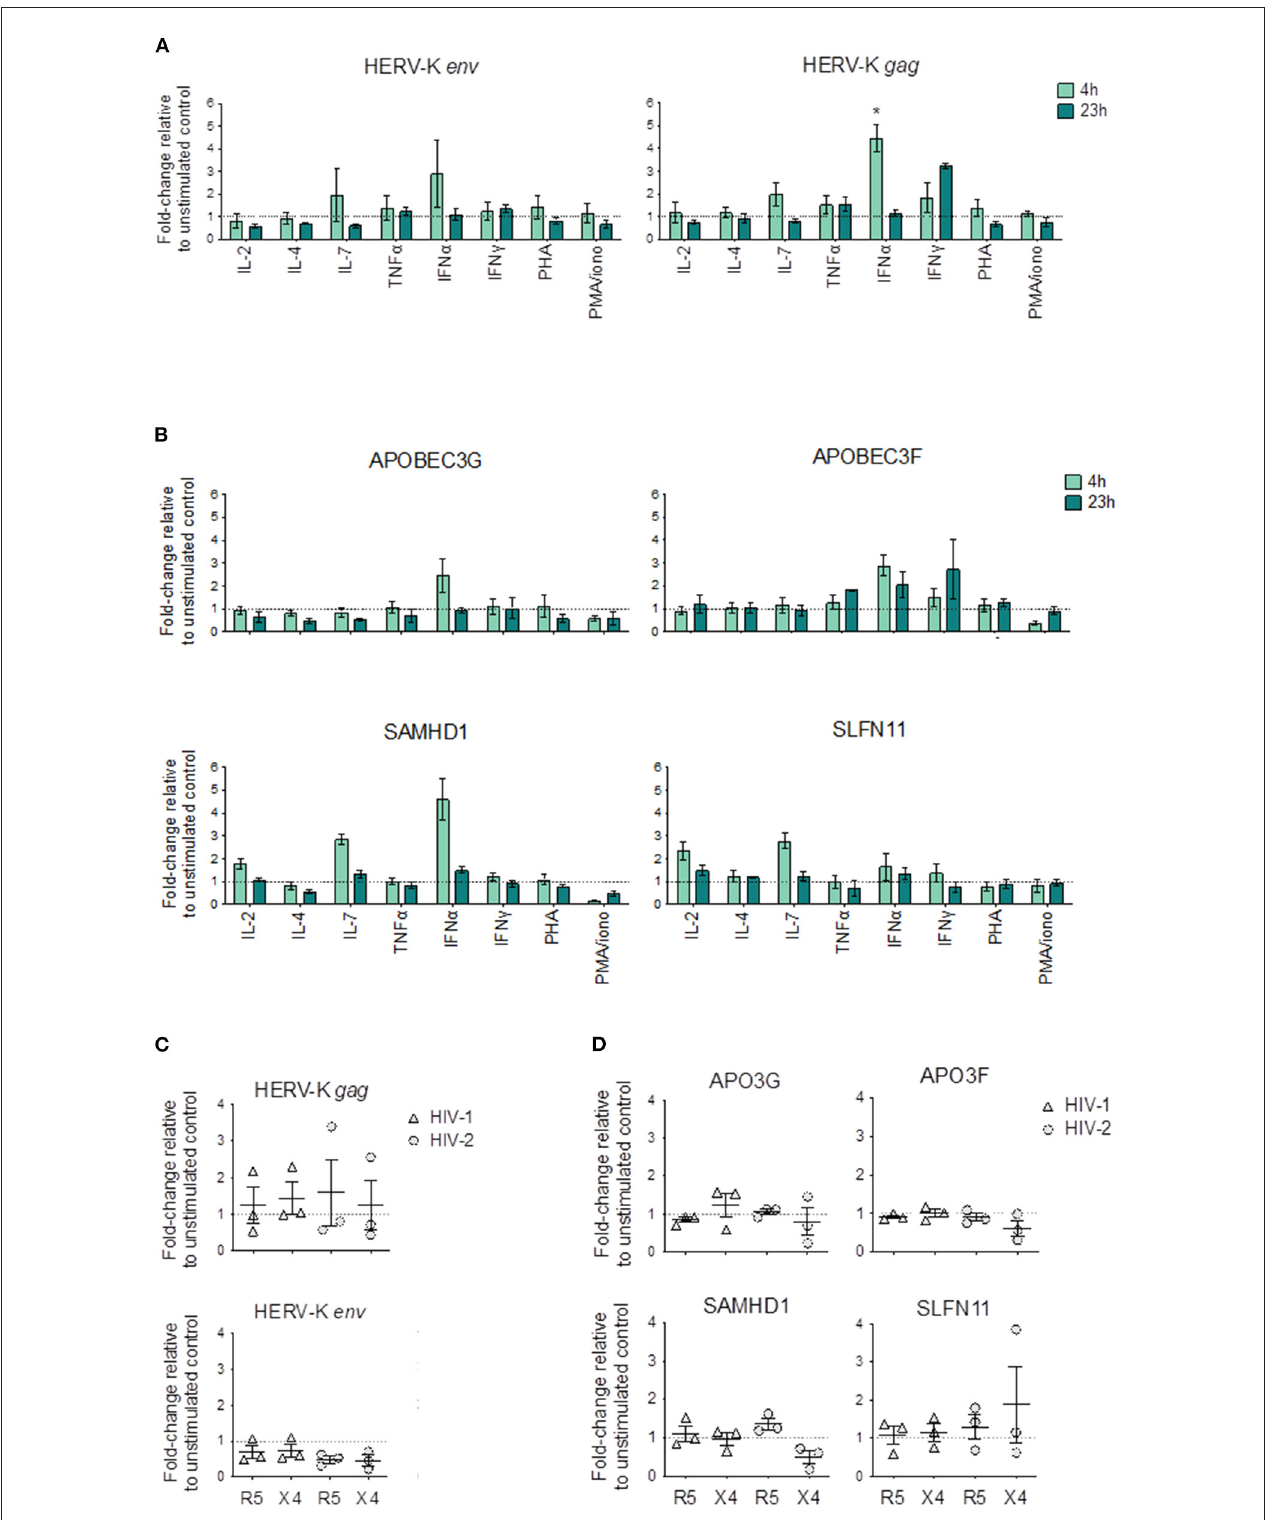
FIGURE 3 | Changes in HERV and HRF transcriptional levels upon cytokine and mitogenic stimulation of CD4SP thymocytes and upon HIV exposure. (A,B) Sorted CD4SP thymocytes were stimulated for 4h (light green) or 23h (dark green) with medium alone or in the presence of IL-2, IL-4, IL-7, TNF- α , IFN- α , IFN- γ , PHA